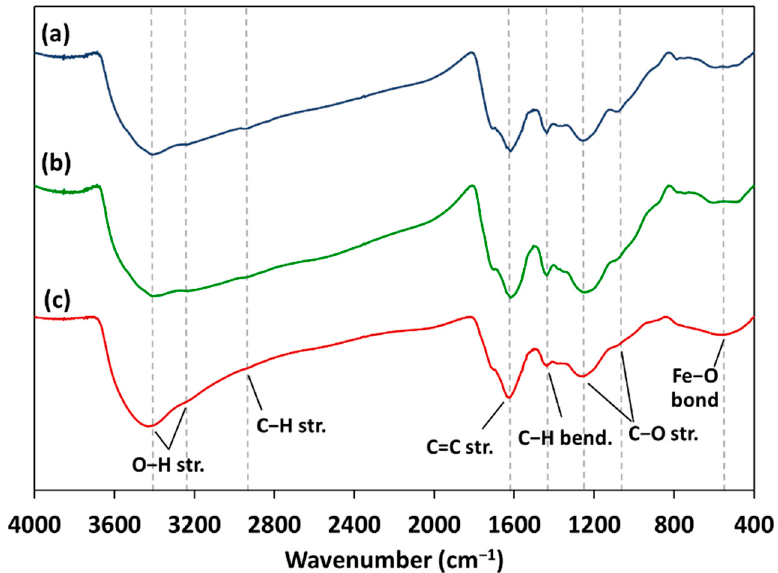
Figure 1. IR spectra of ( a ) catechol-HCP, ( b ) catechol-HCP-w, and ( c ) catechol-HCP-Fe.